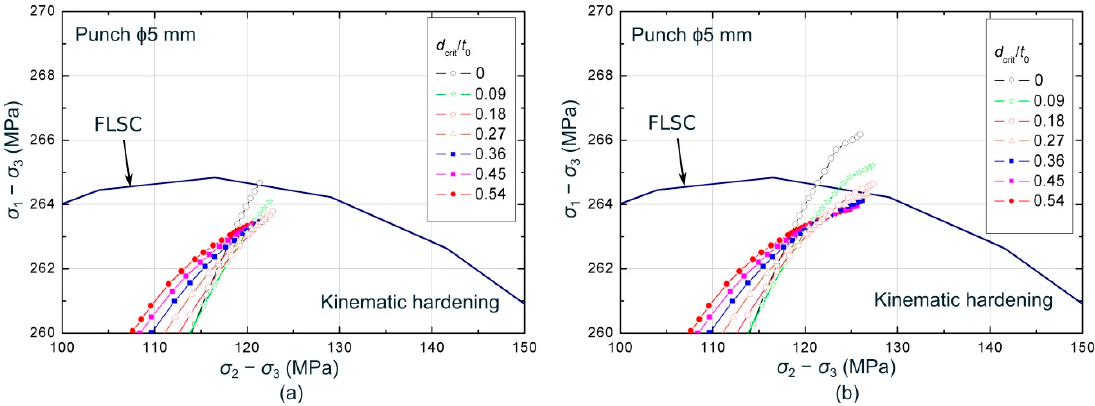
Figure 13. Numerical stresses evolutions, averaged at different values of dcrit, for the φ 5 mm stretch-bending tests at the time instants at which numerical paths for ( a ) dcrit = 0 and for ( b ) dcrit = 0.27 reached the FLSC.